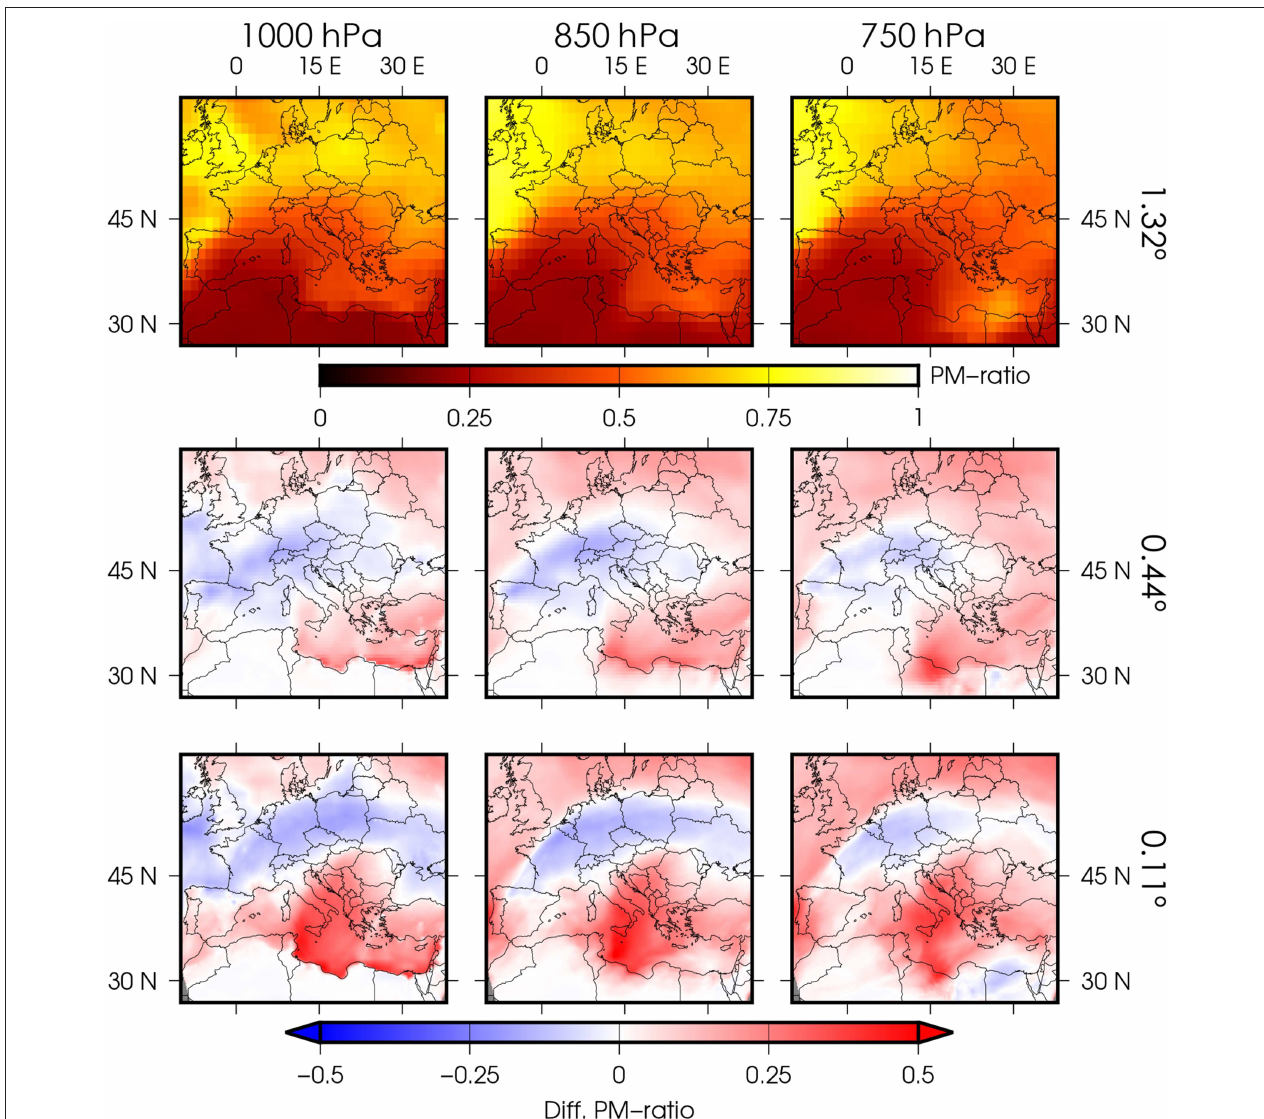
FIGURE 8 | PM-ratio (PM 2.5 /PM 10 ) at 1000 hPa (left column), 850 hPa (middle column), and 750 hPa (right column) of simulation at 1.32 ◦ (top). Second and third rows display differences between simulation at 1.32 ◦ and at 0.44 ◦ and at 0.11 ◦ , respectively.